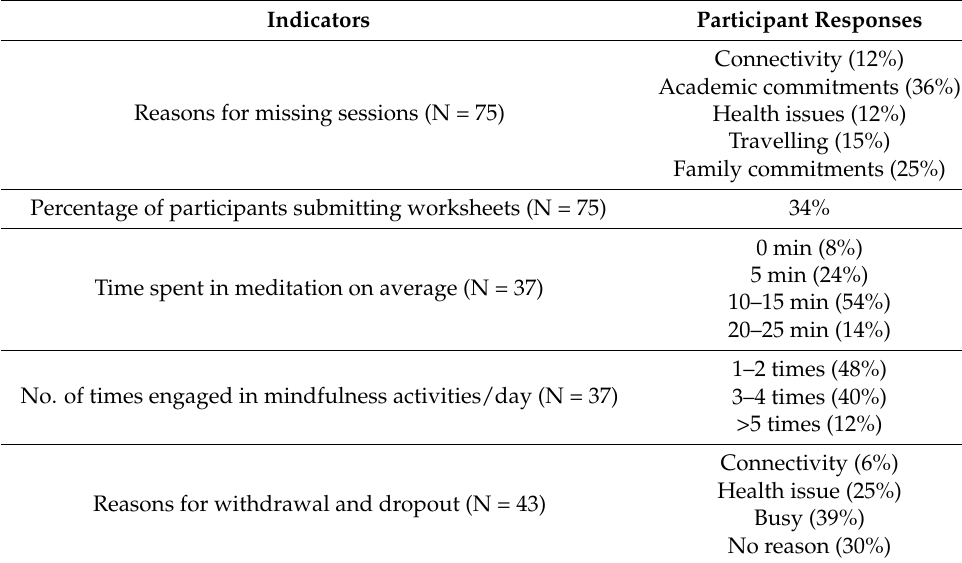
Table 4. Summary of participant engagement with MTC elements: sessions, worksheets, meditations, and mindful activities.